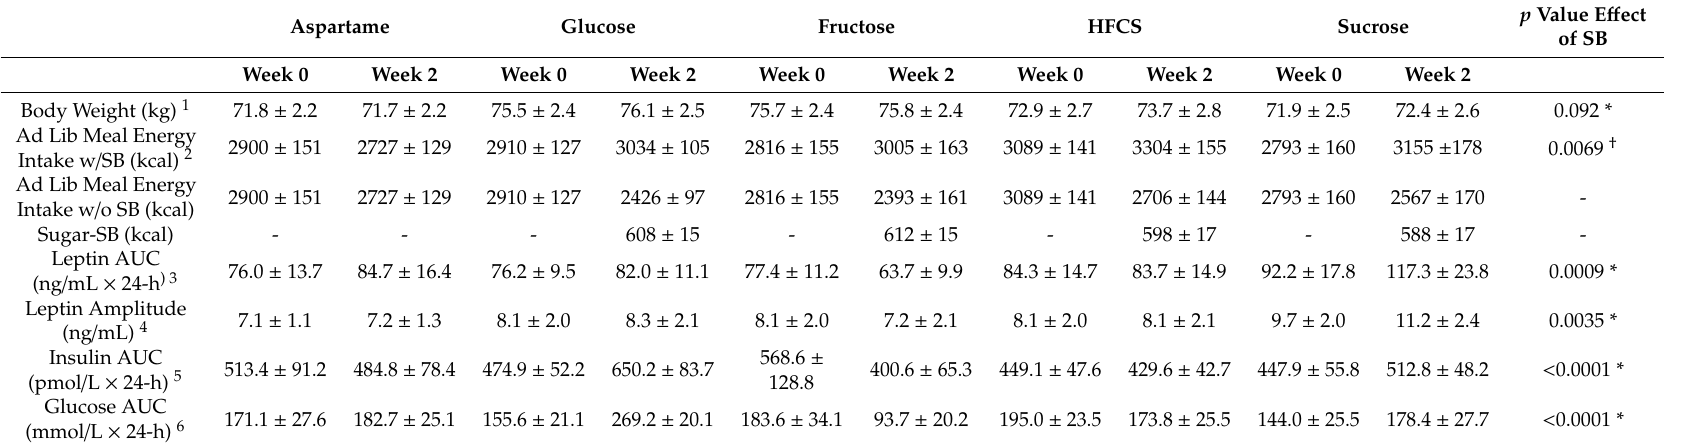
Table 2. Body weight, energy intake during ad libitum food intake trial and 24-h leptin, glucose, and insulin AUC at Week 0 and Week 2 1